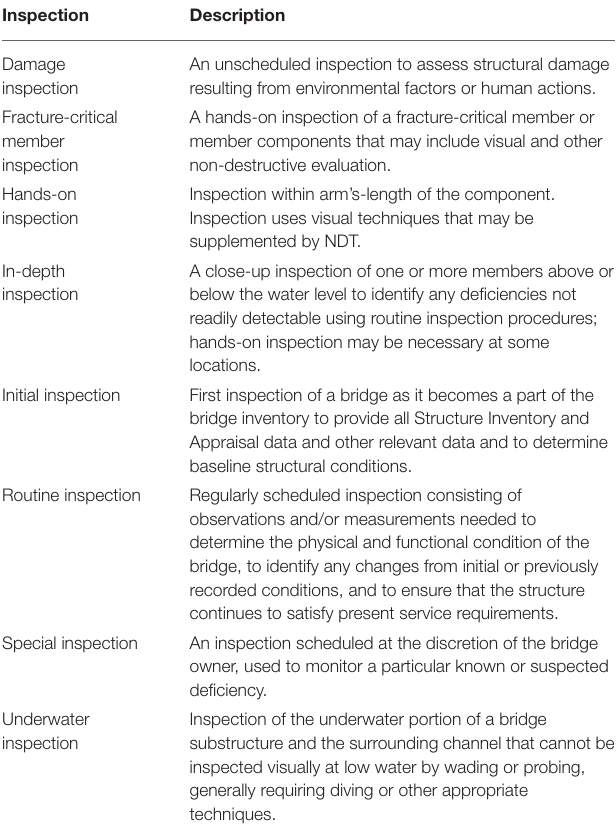
TABLE 3 | U.S. Federally mandated bridge inspection types (Bektas and Albughdadi, 2018).